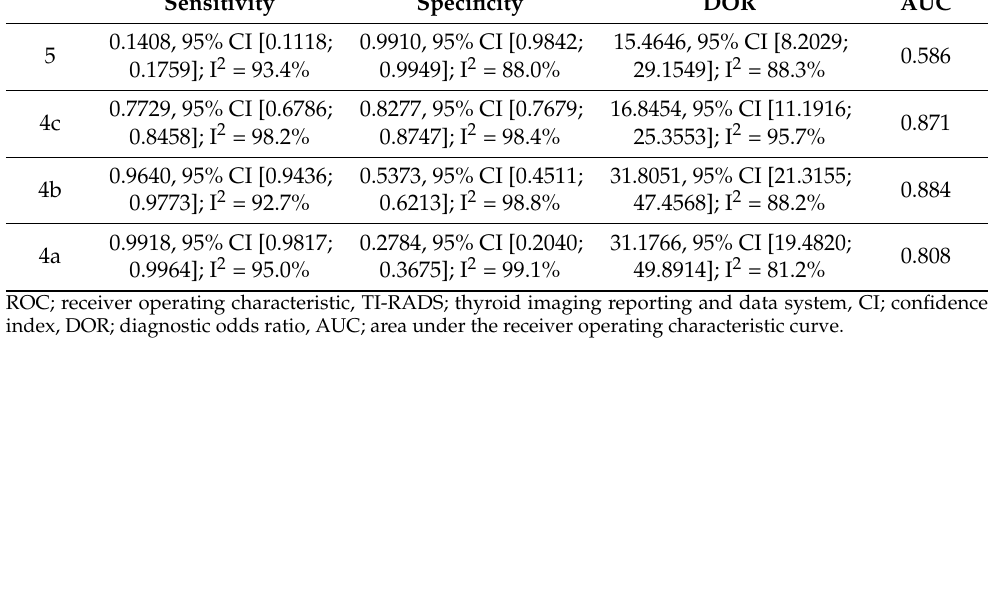
Table 2. Diagnostic efficacy and the ROC curves of ACR TI-RADS categories.